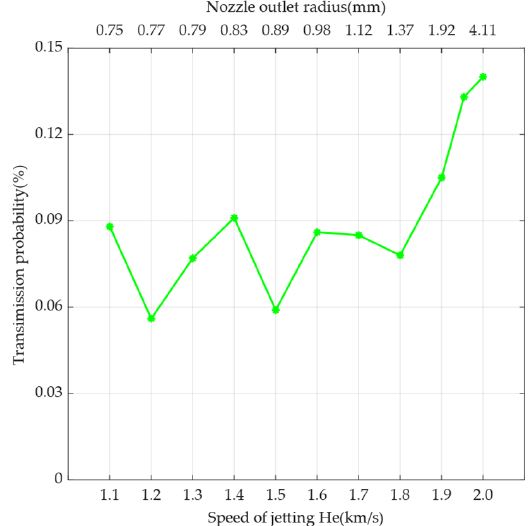
Figure 10. Relationship between the speed of jetting He and transmission probability. The simulation results are indicated by stars in the line graph. The primary x-axis at the bottom indicates the speed of jetting He, and the secondary x-axis at the top indicates the nozzle outlet radius at the corresponding speed. The y-axis indicates the transmission probability, which is the ratio of the number of particles received at the sensor sampling port to the total number of particles.